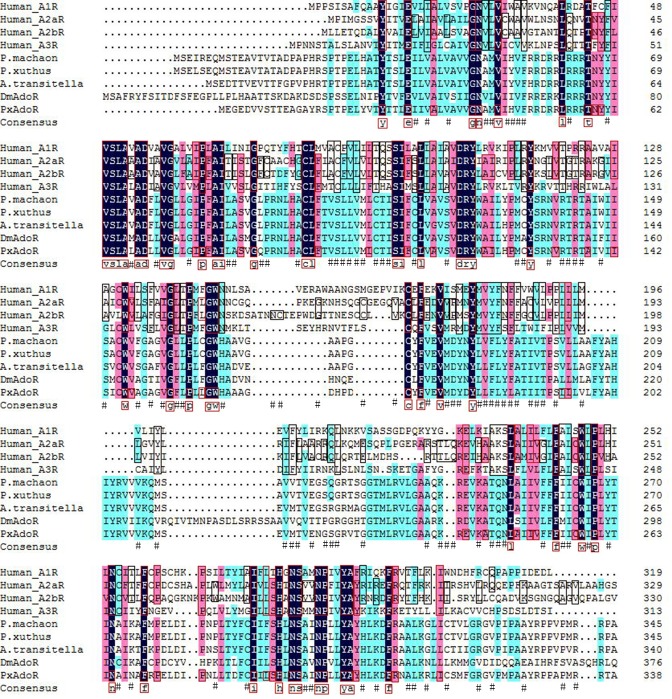
Alignment of the human A2b adenosine receptor and N-terminal part of AdoR amino acids sequences of other insects and Plutella xylostella.Different color shows different homology levels. Black means 100% homology level, pink shows 75% homology level, blue stands for 50% homology level, and yellow marks 33% homology level. The PxAdoR and human adenosine receptors share the same key residues marked by red solid border and the mismatched key residues between PxAdoR and human adenosine receptors are marked by black solid border. “#” sign indicates the special residues of PxAdoR compared with human adenosine receptors.